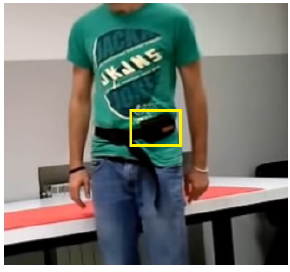
Figure 5. Pedestrian taking the test with smartphone on